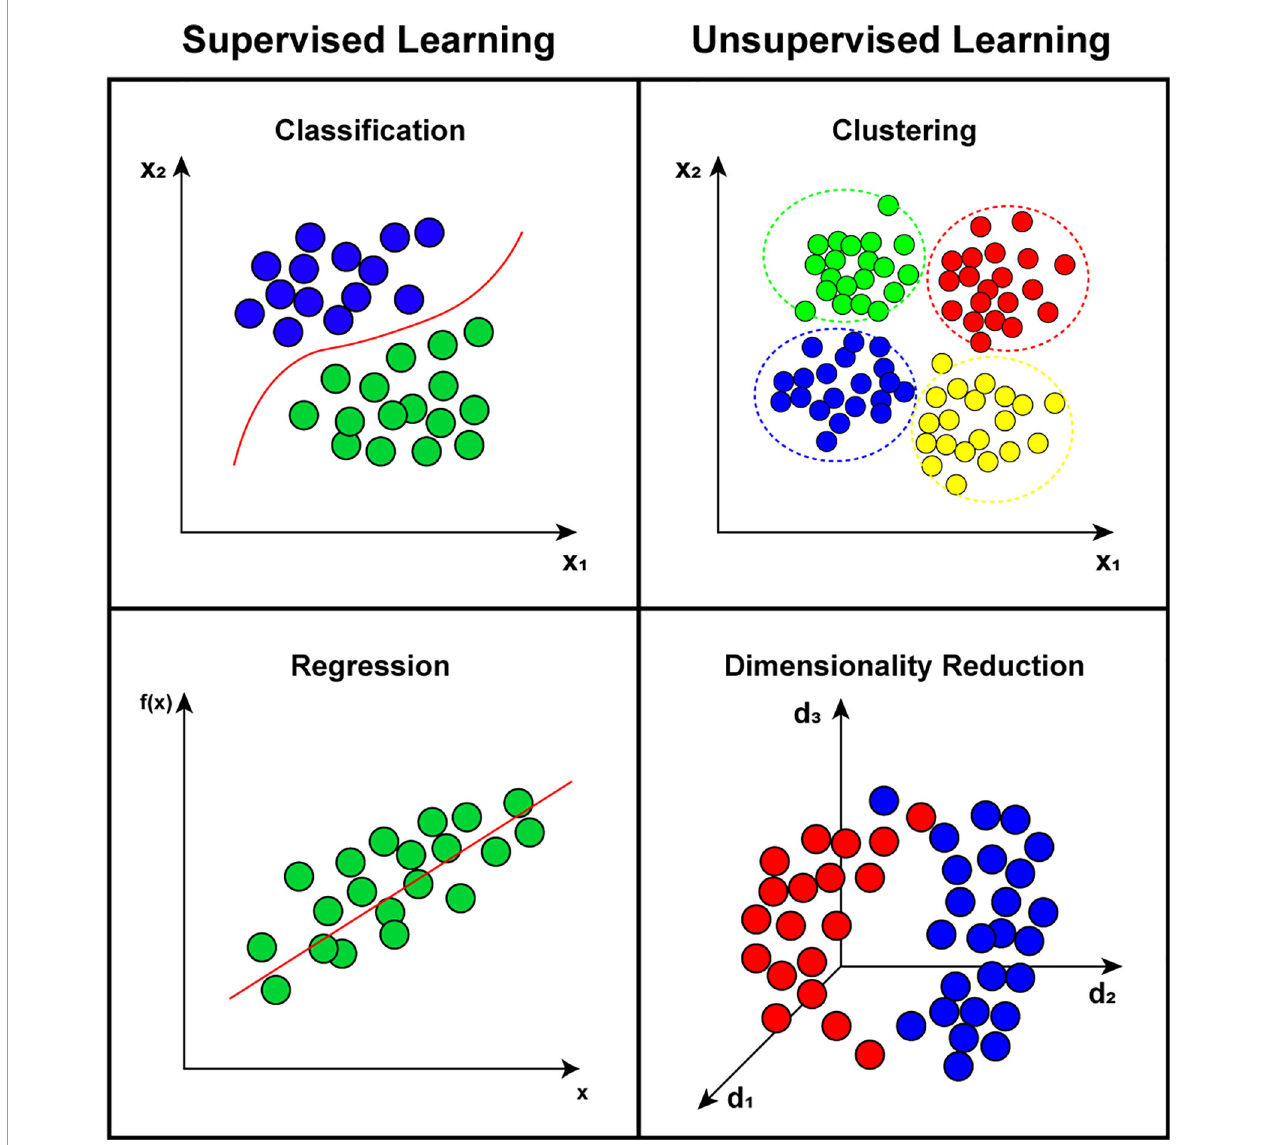
FIGURE 4 | Representation of main categories on machine learning state-of-art, divided between supervised learning, such as classi fi cation and regression problems; and unsupervised learning that includes clustering and dimensionality reduction